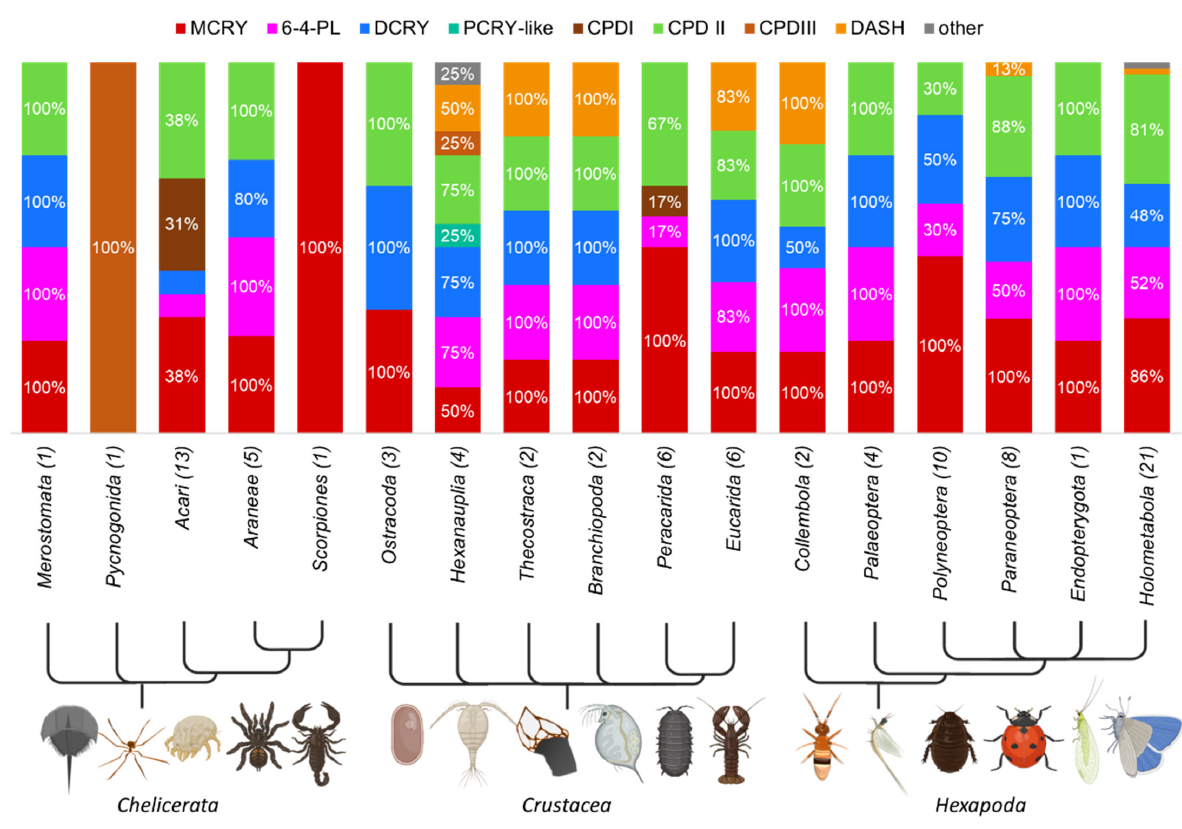
Figure 6. Distribution of CRY/PL subfamilies within the orders of Arthropoda. The occurrence rate of a subfamily within an order is given as a percentage, only percentages > 10% are shown for clarity. The total number of animals studied in each phylum is given in parentheses next to the order name. Chelicerates, crustaceans, and hexapods form the main arthropod subgroup. The major CRY/PL members of arthropods are MCRY, DCRY, and the photolyases 6-4 and CPDII. Many crustaceans also carry the DASH CRY. The four major CRY/PLs are found in all subgroups of the Hexapoda substrain, even though they are not equally abundant in all groups. MCRY is the most important CRY/PL of the hexapods. In Collembola and in individual insects of the cohort Paraneoptera and Holometabola the DASH-CRY is also